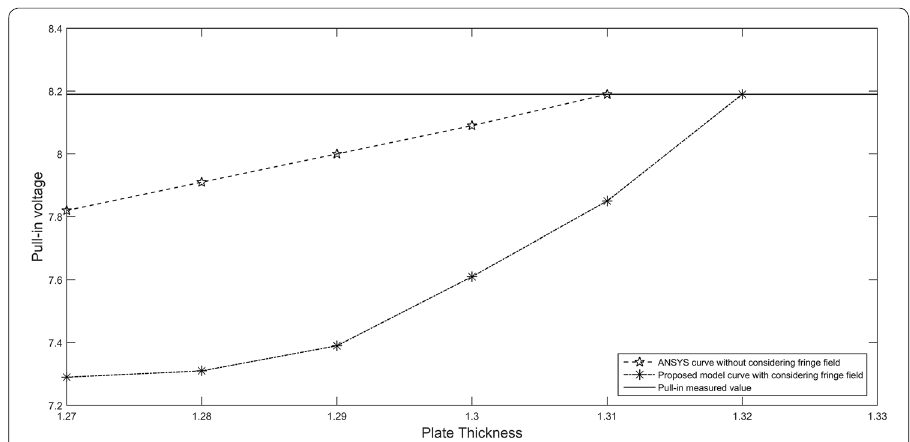
Fig. 7 Comparison between ANSYS software and proposed model results